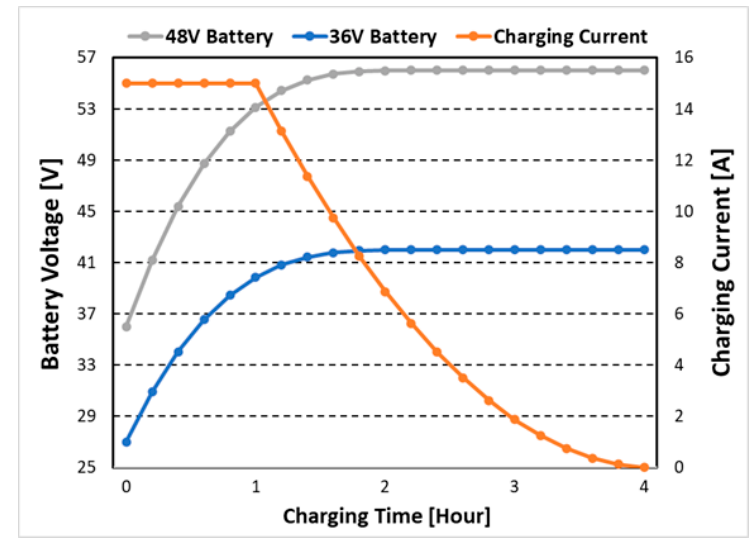
Figure 8. CC ‐ CV control of 36 V and 48 V batteries for electric kickboard. Figure 8. CC-CV control of 36 V and 48 V batteries for electric kickboard. Table 1. Experimental parameters. Table 1. Experimental